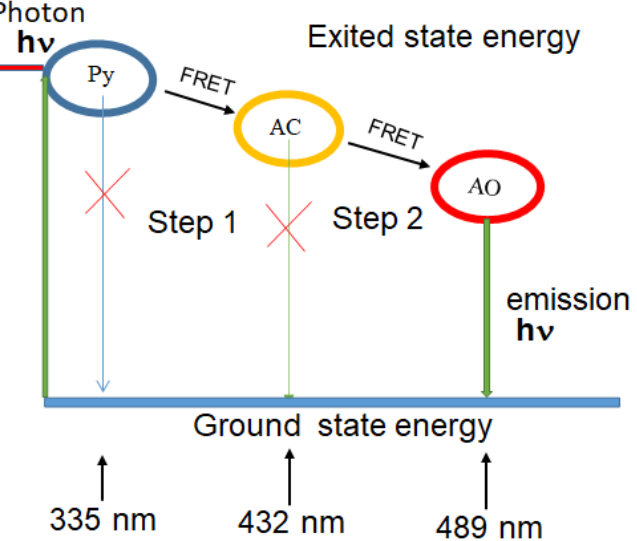
Figure 1. A schematic diagram of the cascade FRET process from donor molecule (Py) through first acceptor molecule (AC) to second acceptor molecule (AO). Wavelengths represent absorption bands.